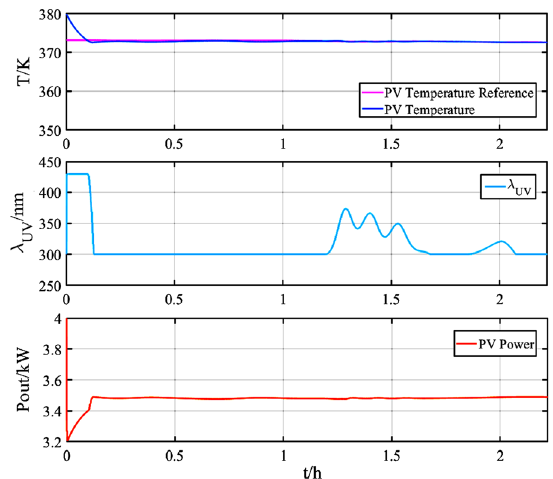
Fig. 7 Simulation results of the MPC controller of PV